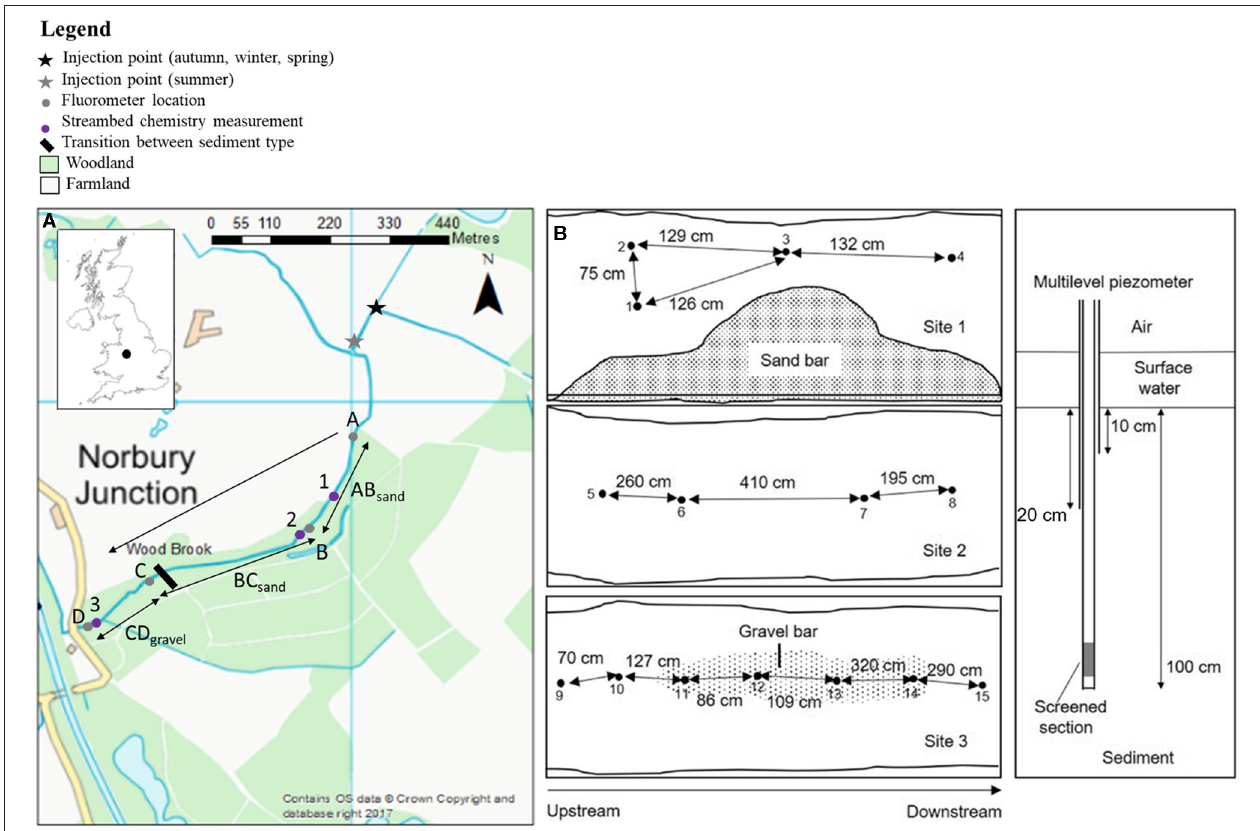
FIGURE 1 | (A) A map of the study site showing the location of the study site within the UK (inset) and the stream experimental sites within the catchment. A–D indicate the fluorometer locations and 1–3 indicate the streambed chemistry sampling sites and (B) The locations and sampler information of the multilevel mini-piezometers used for streambed chemistry sampling. Figure amended from Comer-Warner et al.